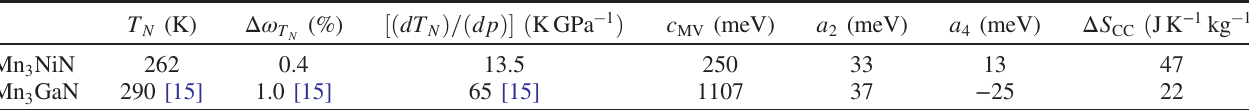
TABLE II. Experimental values of T a 2 , a 4 , and Δ S as described in the text. The latter, Δ S with that determined from calorimetry. The maximum magnetic entropy available for an S ¼ 5 k ln ð 2 S þ 1 Þ in Mn 3 NiN and Mn 3 GaN is 188.2 and 179 . 8 J kg − 1 K − 1 , respectively. As such, the Mn 3 A N family has the potential to B realize much larger entropy